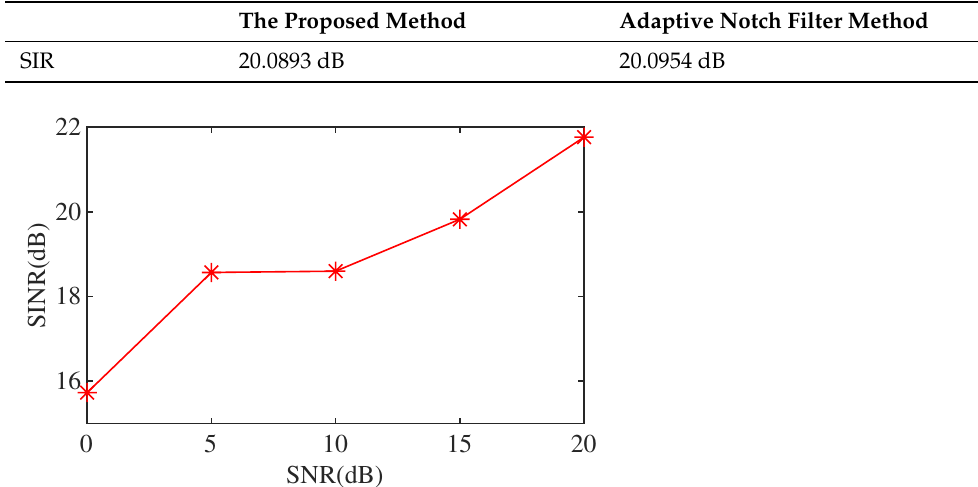
Figure 7. The change of SINR of results after adding white noise with different